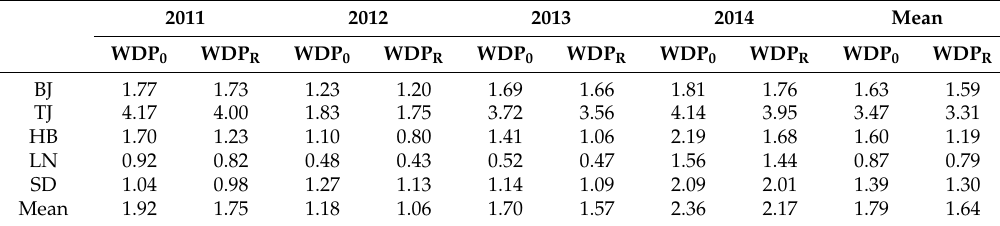
Table 6. Changes of water gradation possibility in Bohai Bay city agglomeration, 2011–2014.